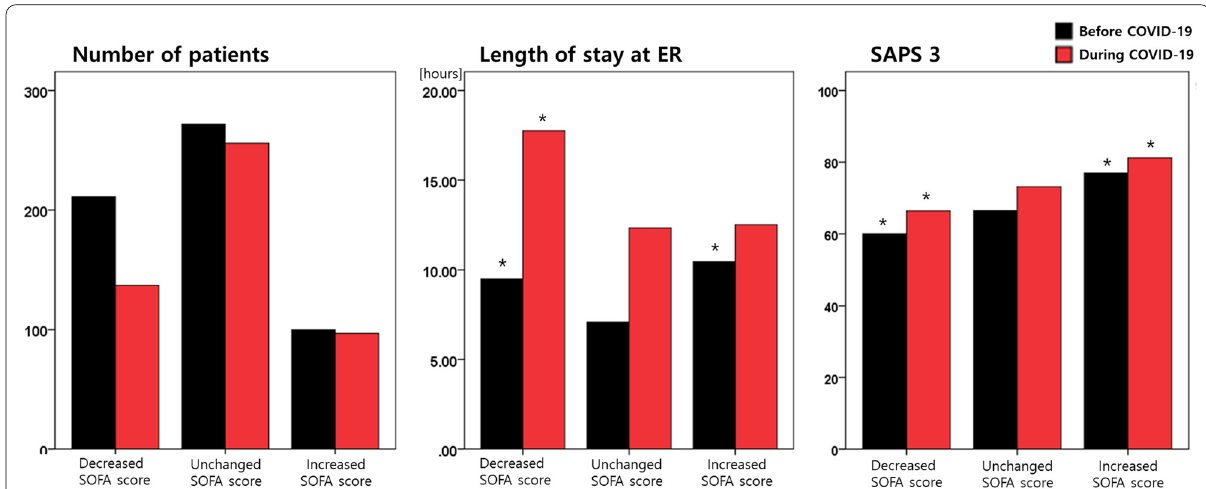
Fig. 2 Characteristics of patients by changes in SOFA scores during emergency department care. ( a ) Patient numbers, ( b ) length of stay in the ER, and ( c ) SAPS 3 in each group. * p < 0.05, compared to the values in the patient group with unchanged SOFA scores. SOFA, Sequential Organ Failure Assessment; ER, emergency room; SAPS 3, Simplified Acute Physiology Score, version 3